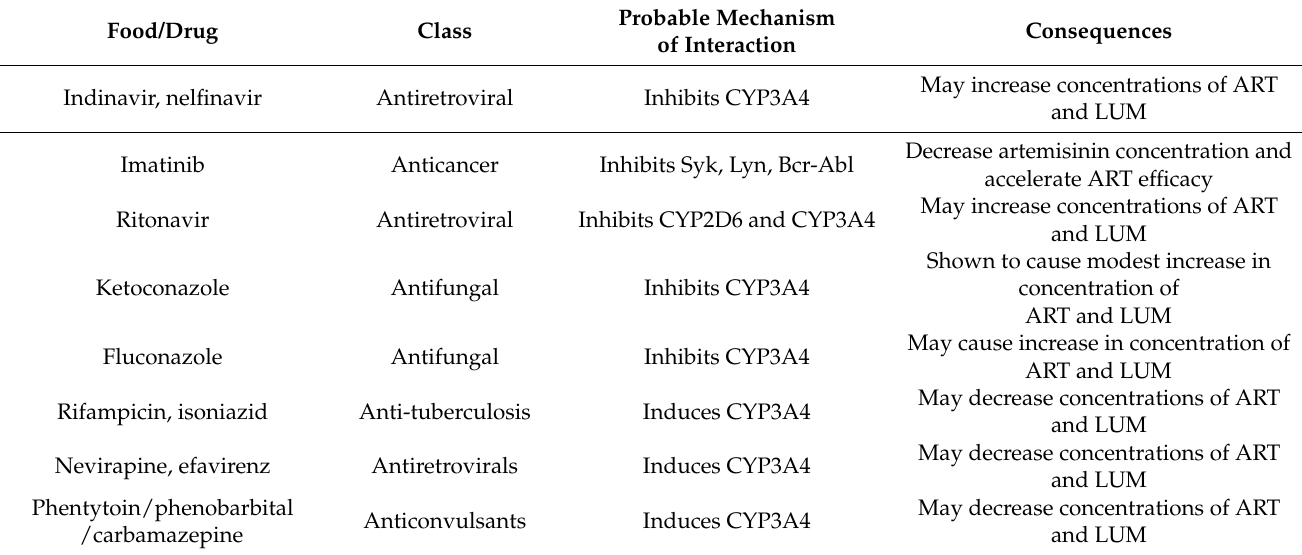
Table 3. Drugs interacting with